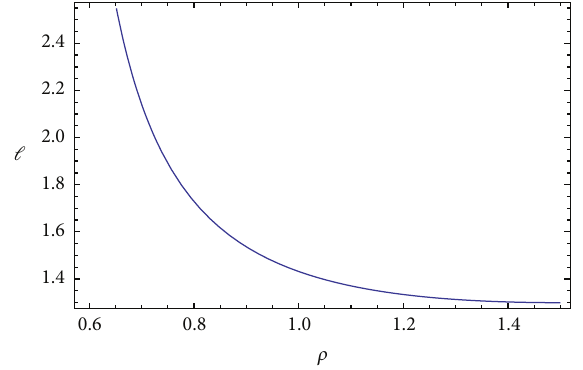
Figure 8: Angular momentum as a function of 𝜌 .